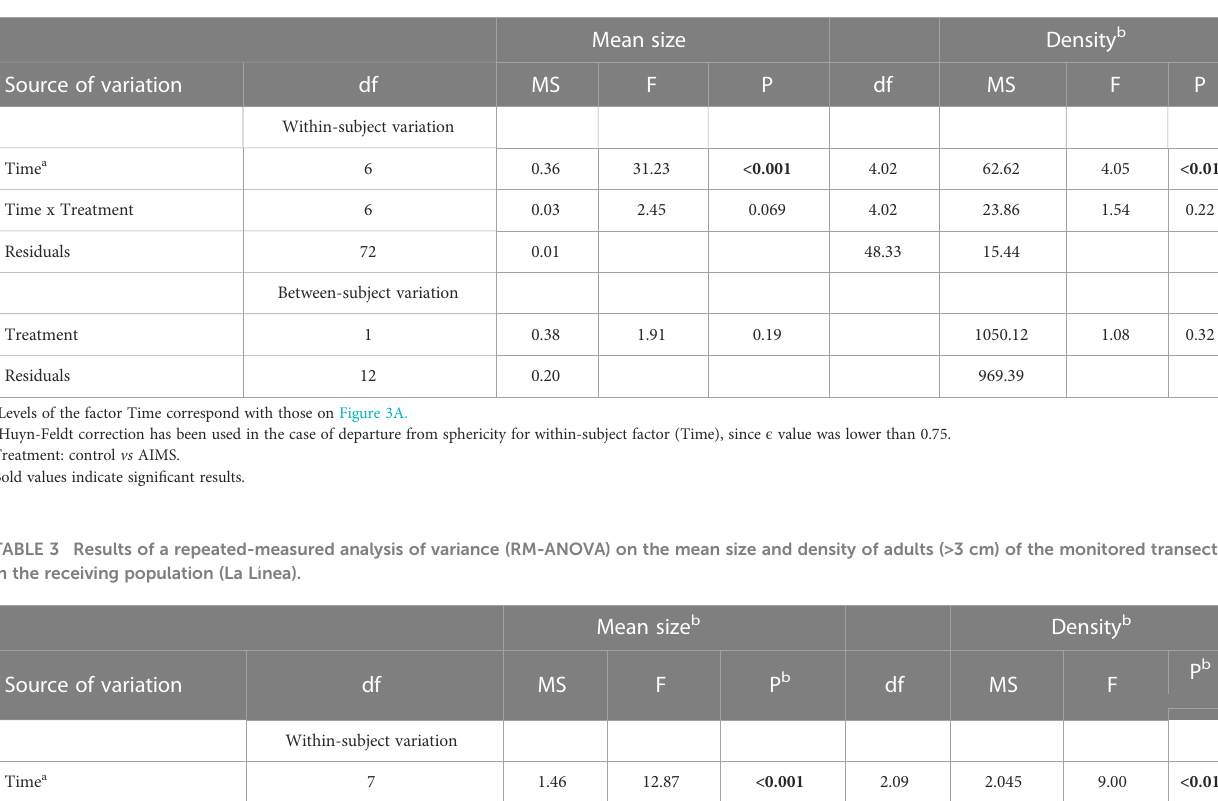
TABLE 2 Results of a repeated-measured analysis of variance (RM-ANOVA) on the mean size and density of adults (>3 cm) of the monitored transects in the donor population